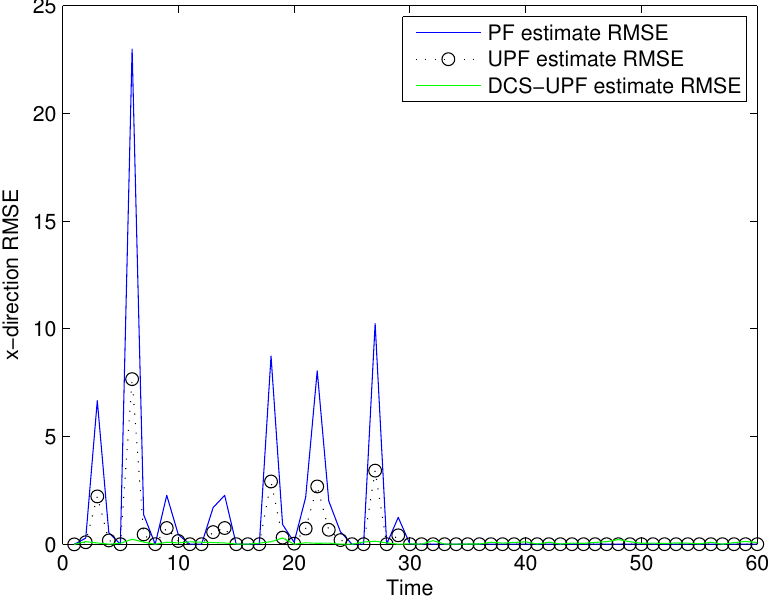
Figure 8. The tracking errors of three methods in X-direction by changing R and